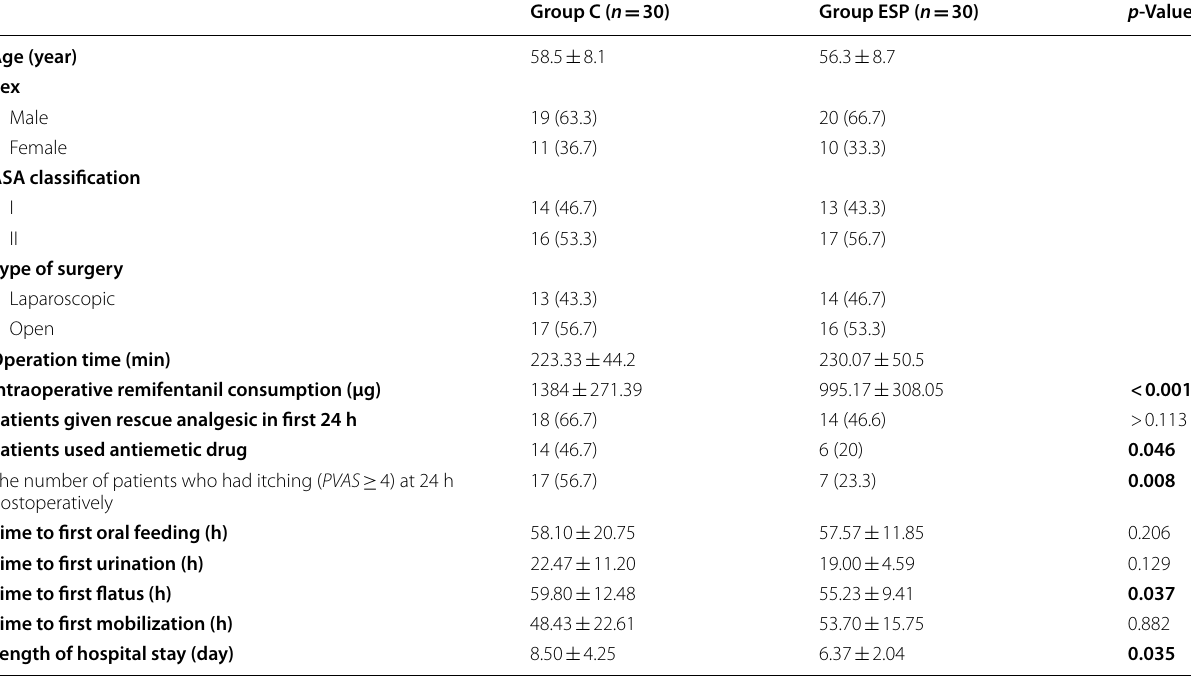
Table 1 Patient demographic and surgical characteristics and clinical outcomes